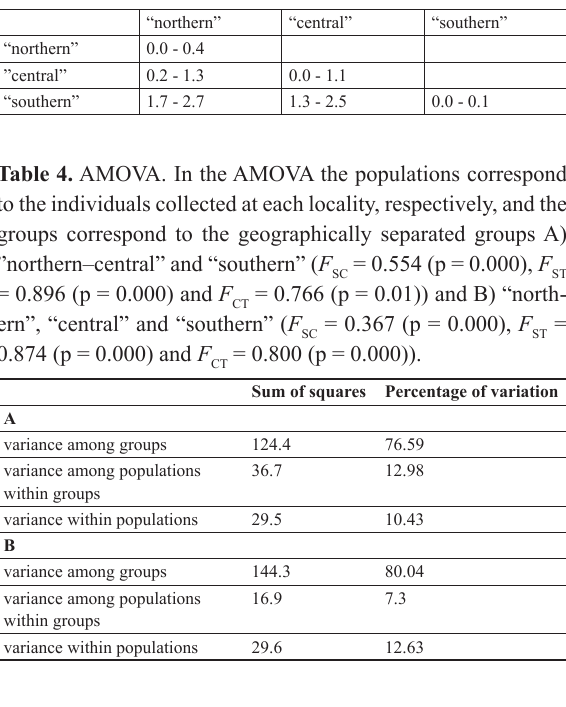
Table 3. Uncorrected p -distances within and between groups in percent.